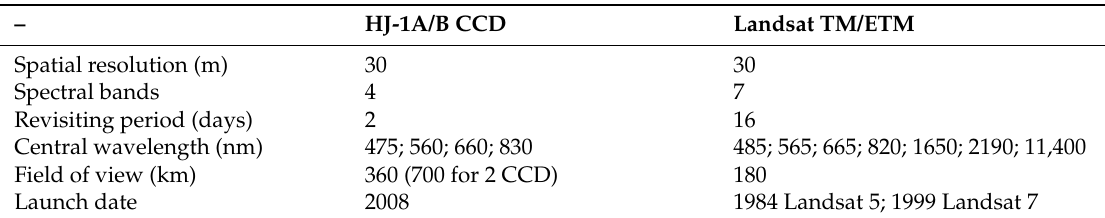
Table 1. Comparison of the characteristics between HJ-1A/B CCD and Landsat TM/ETM.